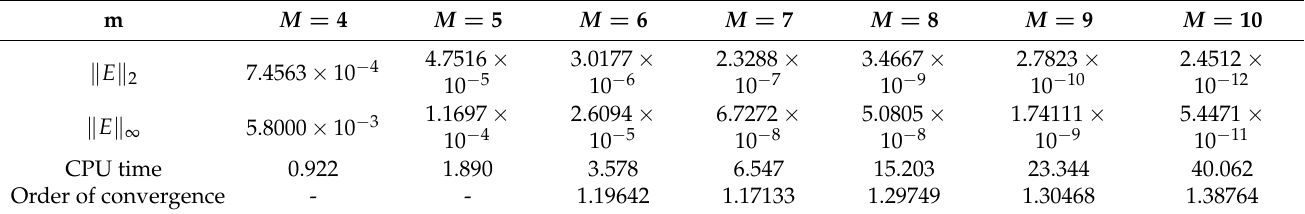
Table 3. The L ∞ , L 2 errors and CPU time for Example 2.